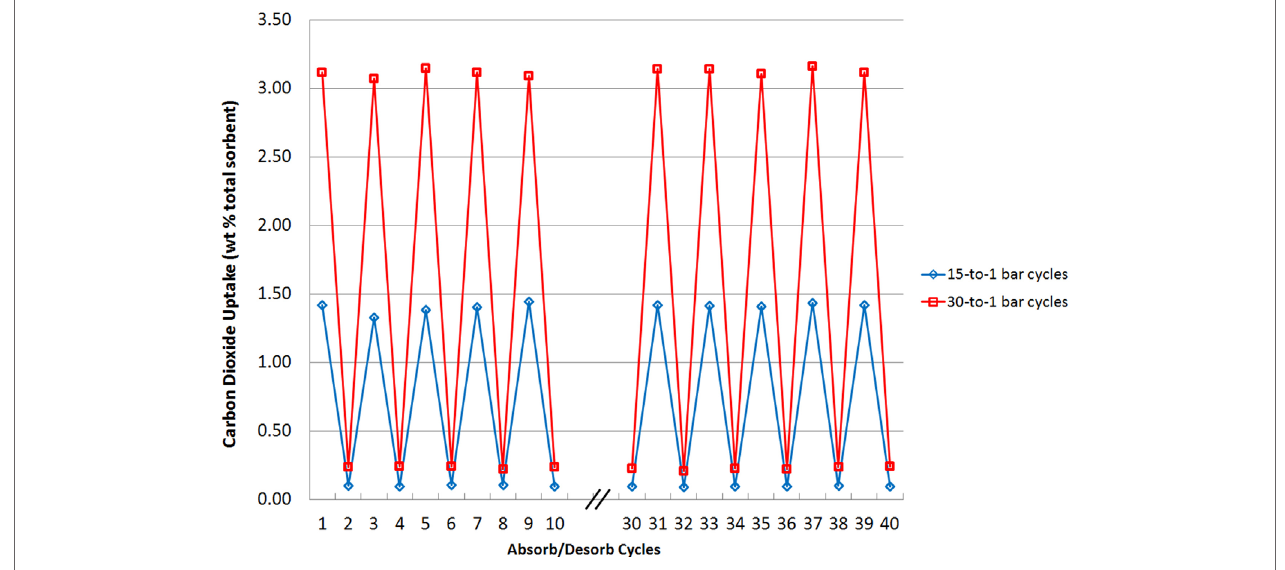
FigUre 11 | Sorbent stability over repeated 1-min adsorb/desorb cycles at two pressures. Desorption is carried out in each case at 1 bar